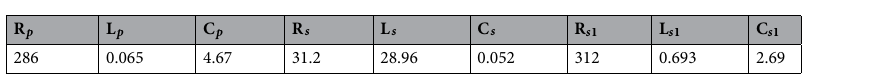
Table 2. Optimized RLC components for notched bands (R in (cid:31) , L in nH, and C in PF).